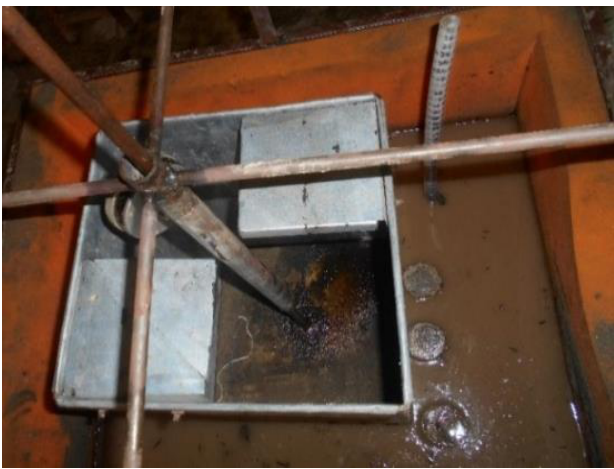
Fig. 11. Columns were un-damaged due to intactness